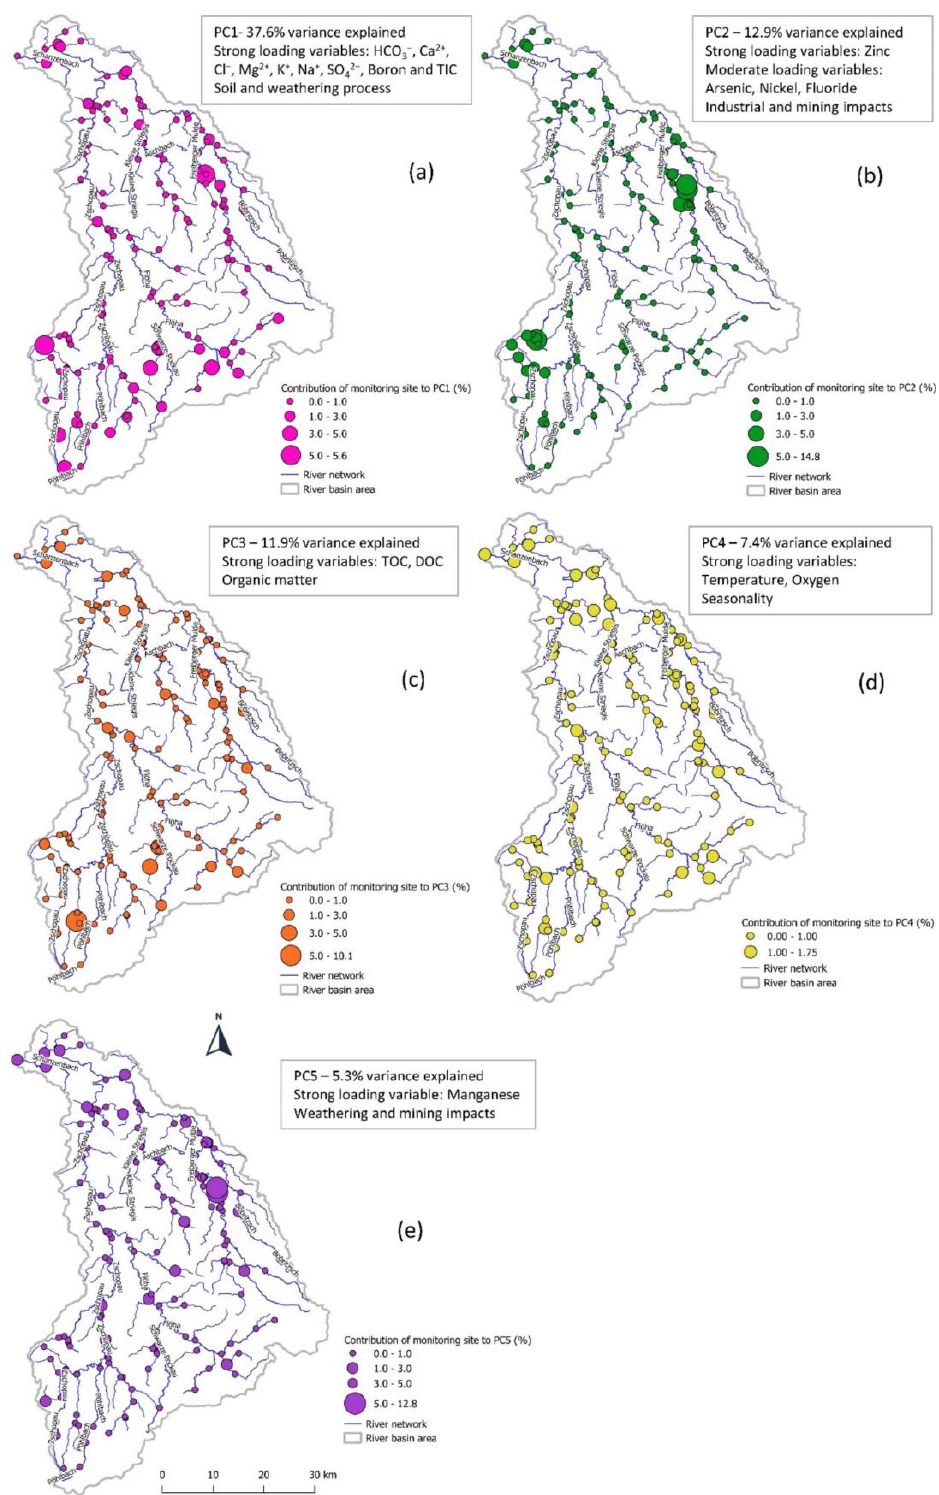
Figure 4. Spatial variation of the five major factors in explaining the data variability in Freiberger Mulde river basin based on the contribution of monitoring sites to ( a ) Principal component 1—weathering and leaching processes, ( b ) Principal component 2—industrial and mining impacts, ( c ) Principal component 3—organic matter, ( d ) Principal component 4—seasonality, ( e ) Principal component 5—weathering and mining impacts.